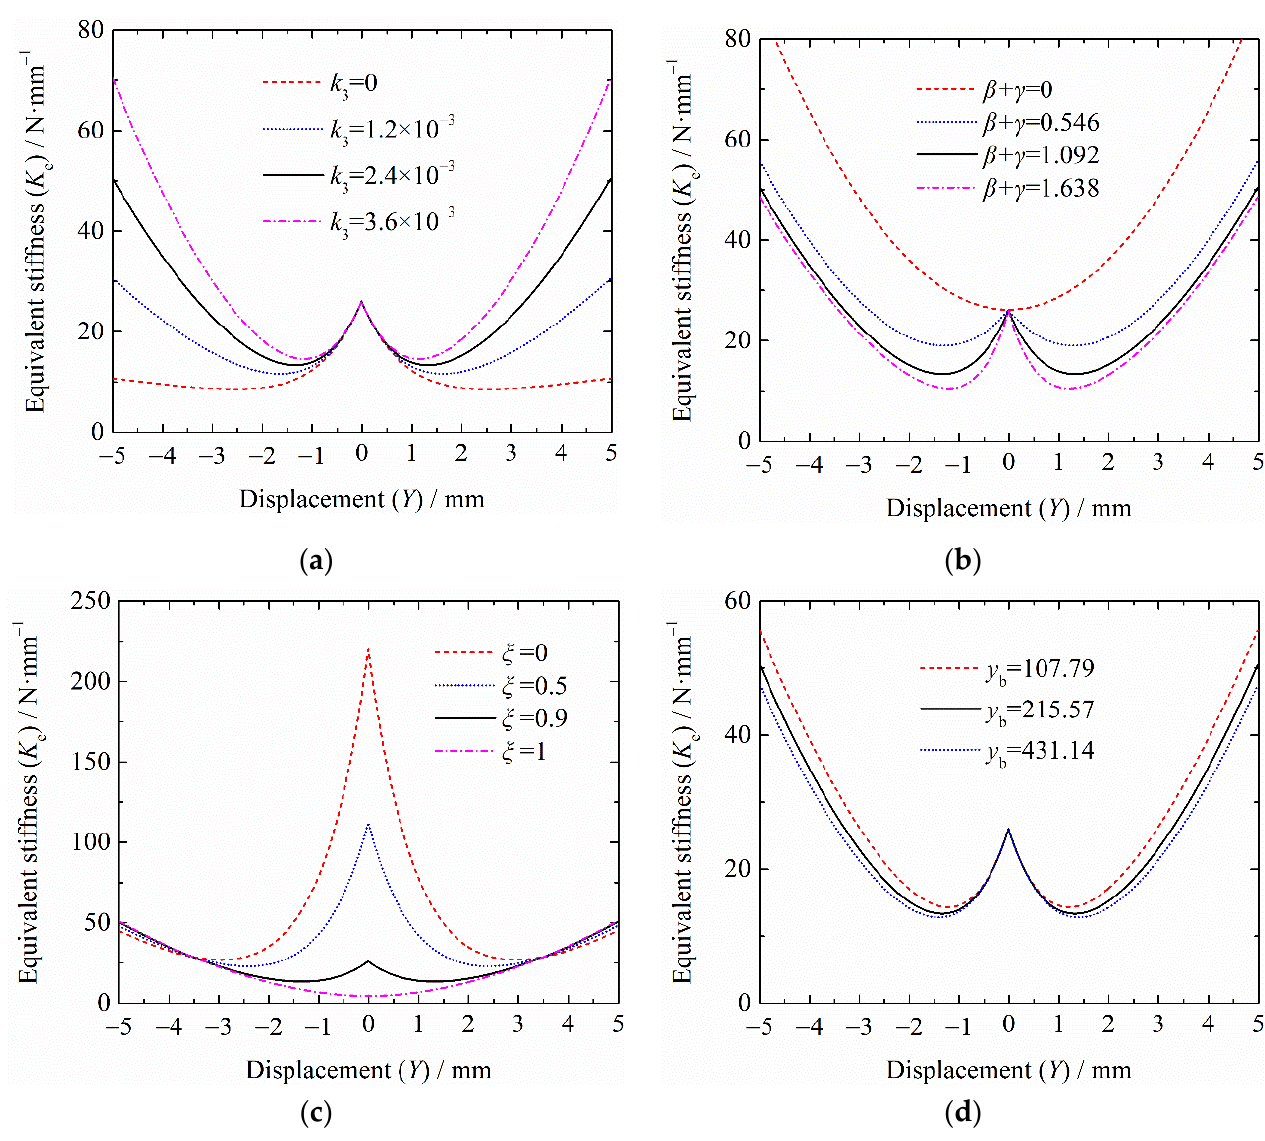
Figure 4. The generalized equivalent stiffness of the isolator with different ( a ) cubic stiffness k 3 , ( b ) Bouc–Wen model parameters ( β + γ ), ( c ) pinching parameters ξ , and ( d ) pinching parameters y b .